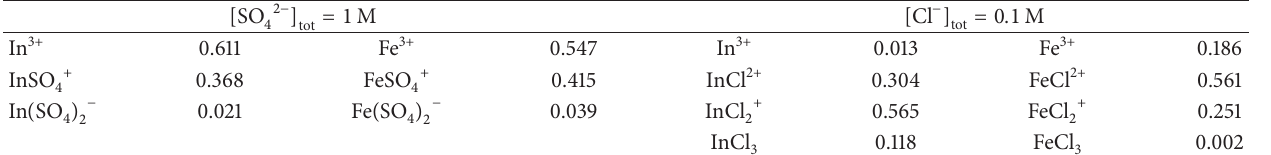
Table 2: Calculated molar fractions of sulfate and chloride species.